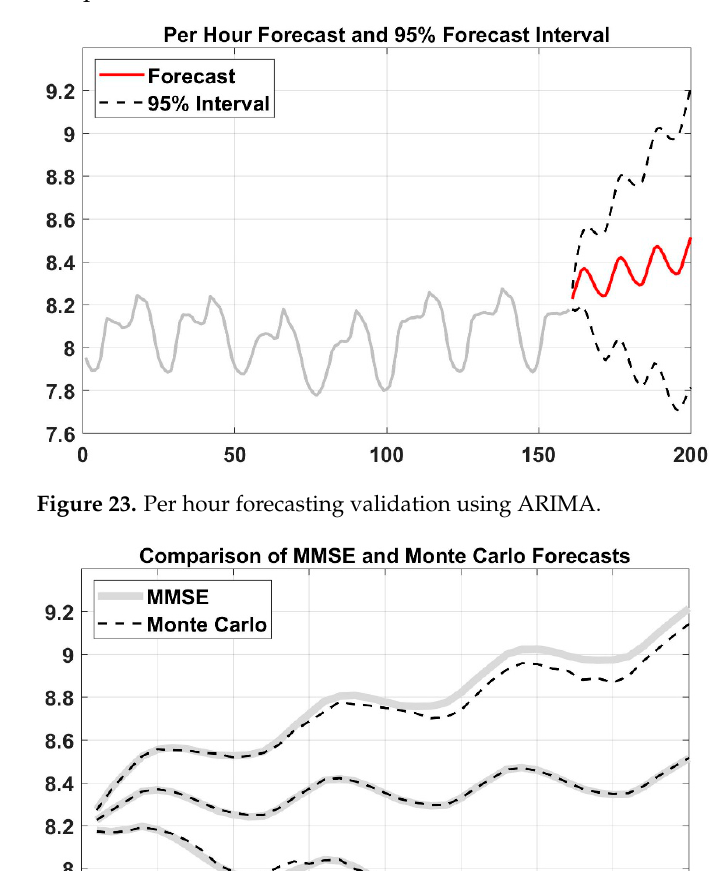
Figure 25. Per day forecasting validation using ARIMA. Figure 26. Per day forecasting validation using MC.